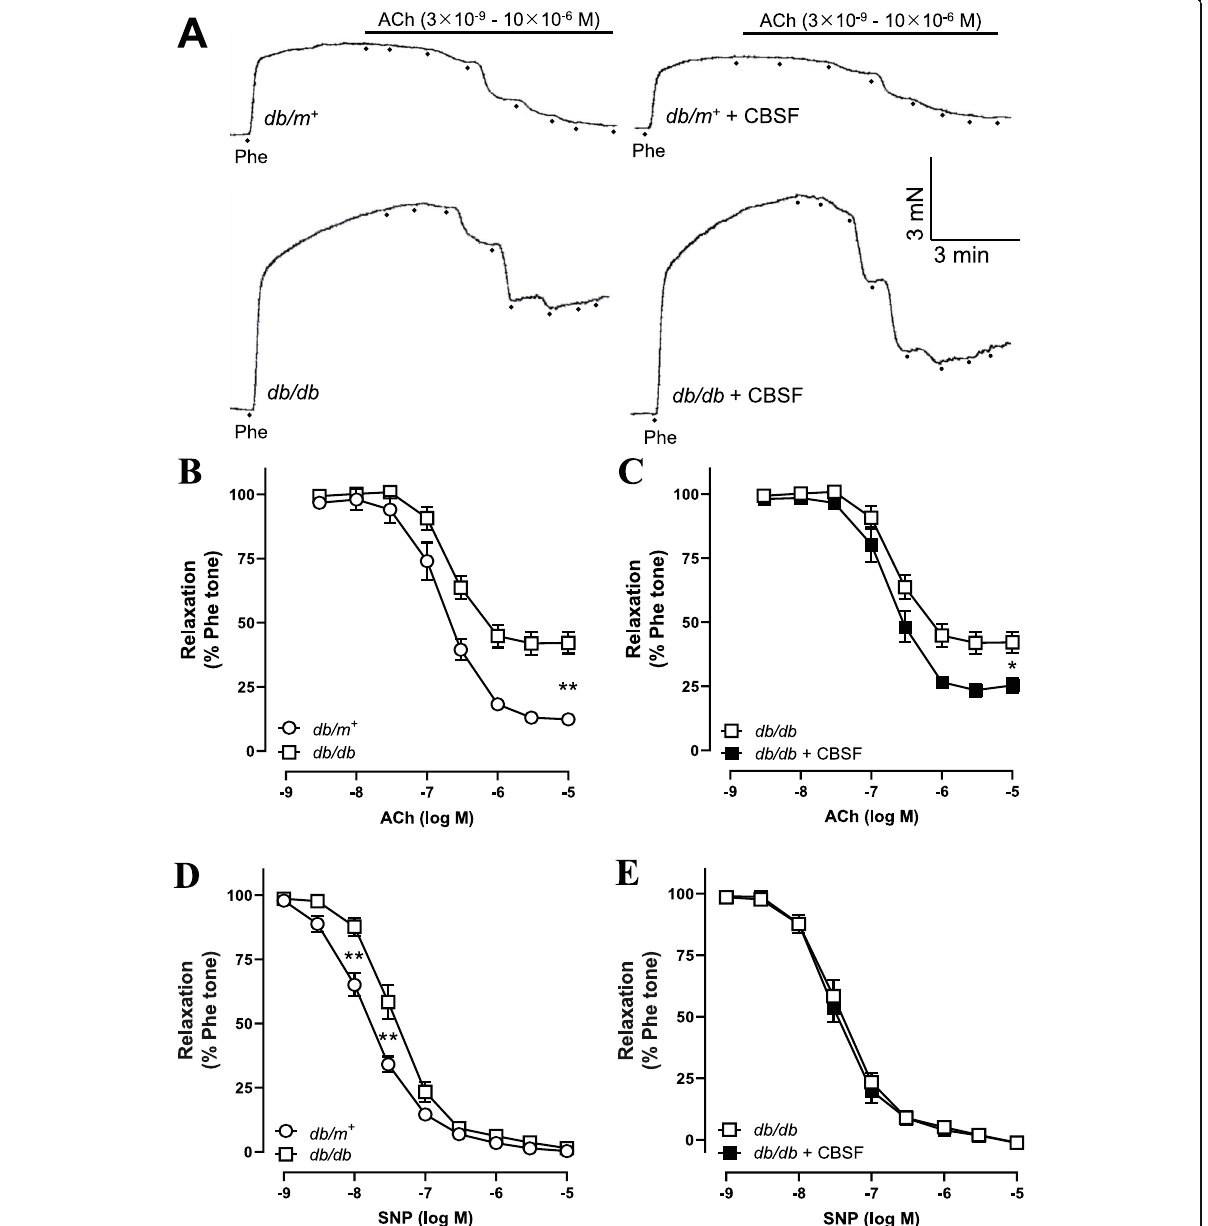
Fig. 2 Oral CBSF treatment improved the impaired endothelial-dependent relaxation (EDR) in db/db mouse aortae. Representative tracings ( a ) with summarized data ( b-c ) of EDR measured by wire myograph in isolated aortae from db/m + and db/db mice with and without in vivo CBSF treatment (25 mg/kg/day). Summarized data of endothelium-independent relaxation of isolated aortae from db/m + and db/db mice treated or non-treated with CBSF ( d-e ). Data are presented in mean ± SEM; n = 8, * p < 0.05 and ** p < 0.01 relative to db/db . CBSF, crocodile blood soluble fraction; Phe, phenylephrine; ACh, acetylcholine; SNP, sodium